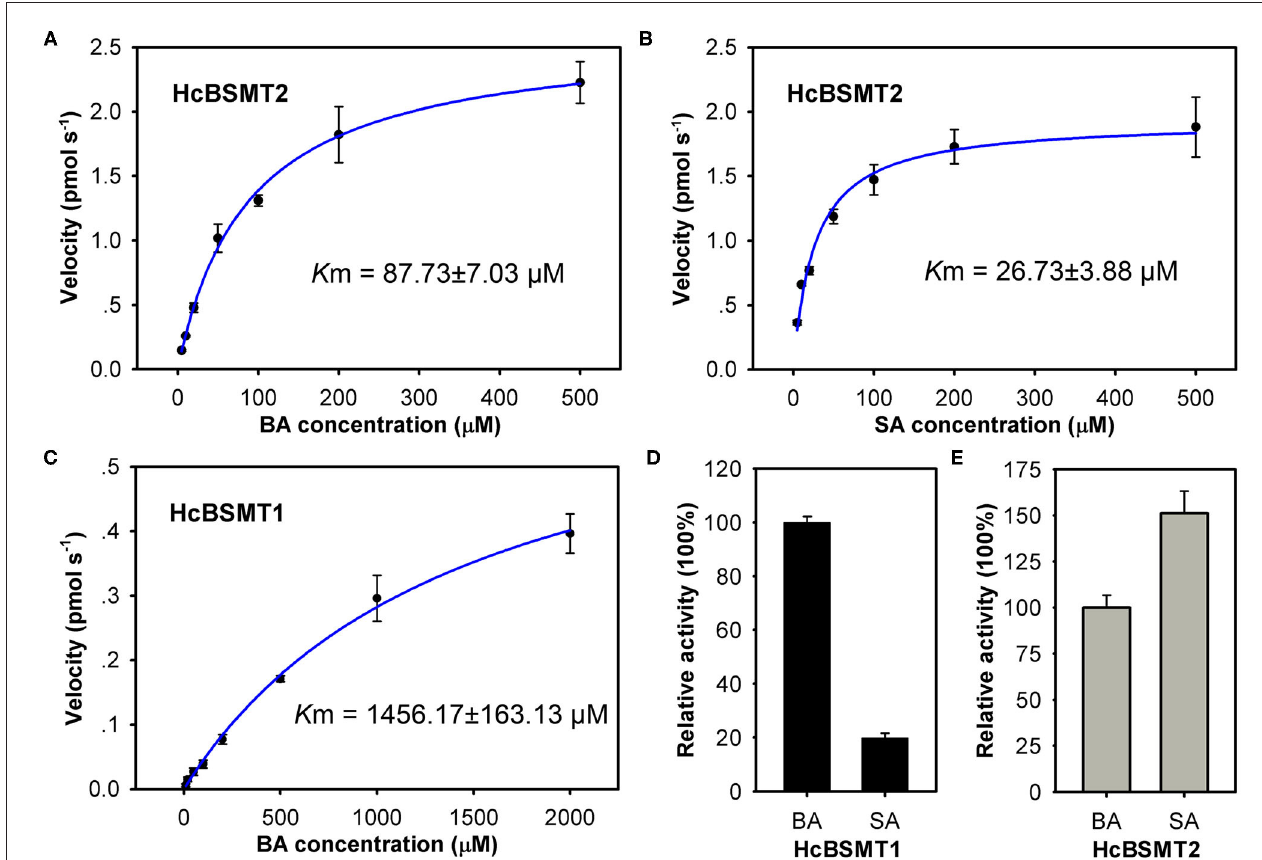
FIGURE 5 | Biochemical characterization of recombinant HcBSMTs proteins. (A,B) Kinetic analysis for HcBSMT2 under different benzoic acid (BA) and salicylic acid (SA) concentrations. (C) Kinetic analysis for HcBSMT1 under different BA concentrations. The saturation curves were generated using Michaelis–Menten equation by hyperbolic regression. (D) Relative activity of HcBSMT1 with BA and SA. (E) Relative activity of HcBSMT2 with BA and SA. The activity of two enzymes with BA was set to 100%. Error bars indicate standard deviation of three independent